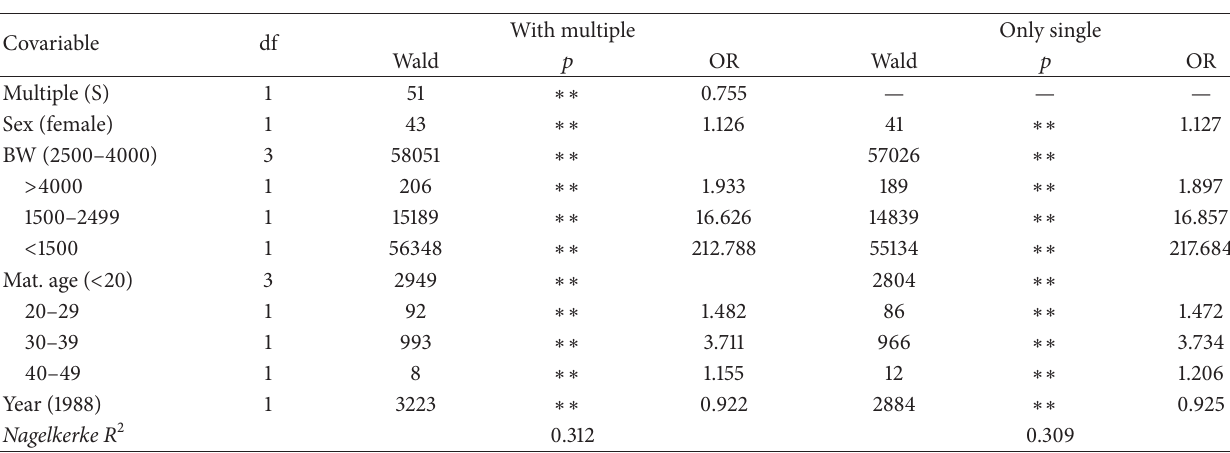
Table 3: (a) 1988–95 and 2010-11 forward (Wald) binary logistic regression parameters. Dependent variable: stillbirths ( ≥ 500 grams regardless of duration of gestation). (b) 1988–95 and 2010-11 forward (Wald) binary logistic regression parameters. Dependent variable: stillbirths (duration of gestations ≥ 22